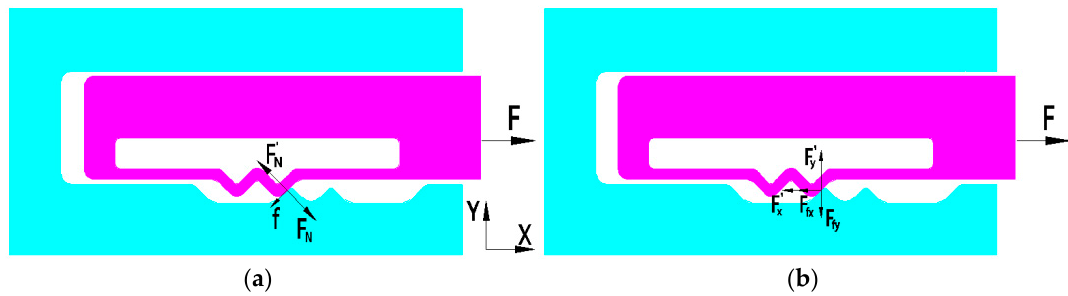
Figure 5. The force of elastic-beam delaying mechanism: ( a ) overall view, ( b ) decomposition view.